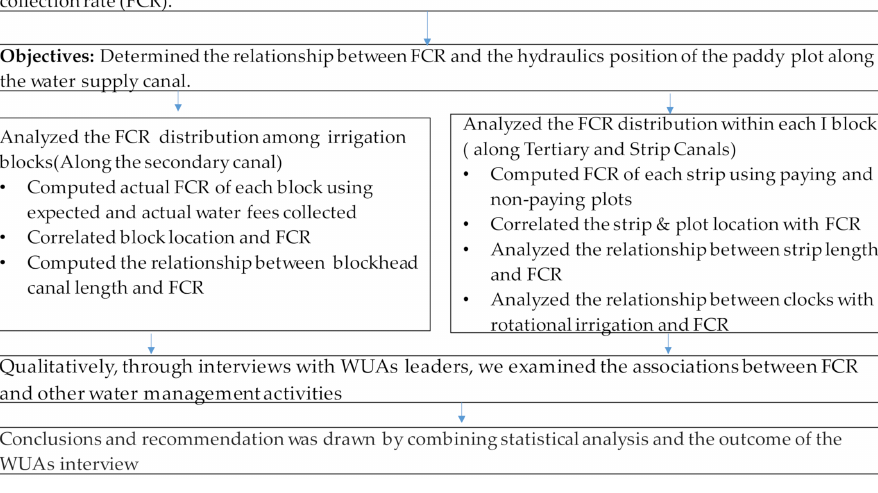
Figure 2. The logical flow of the entire research